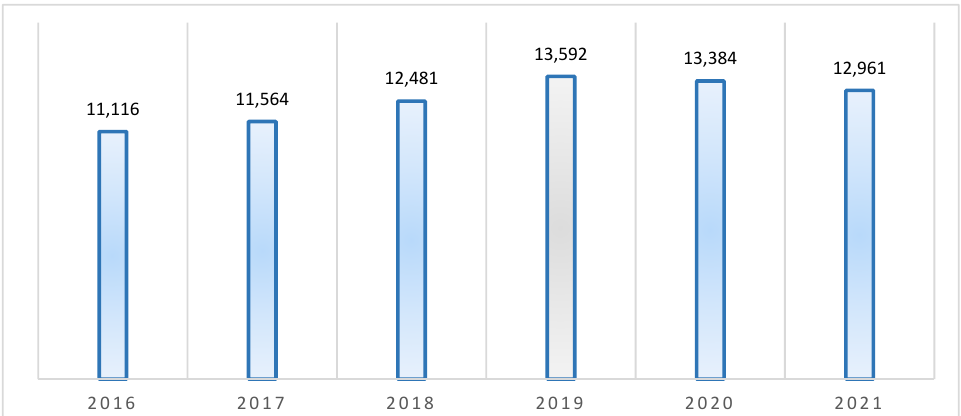
Figure 2. Year-wise publication trend based on record count of publications for 2016–2021.